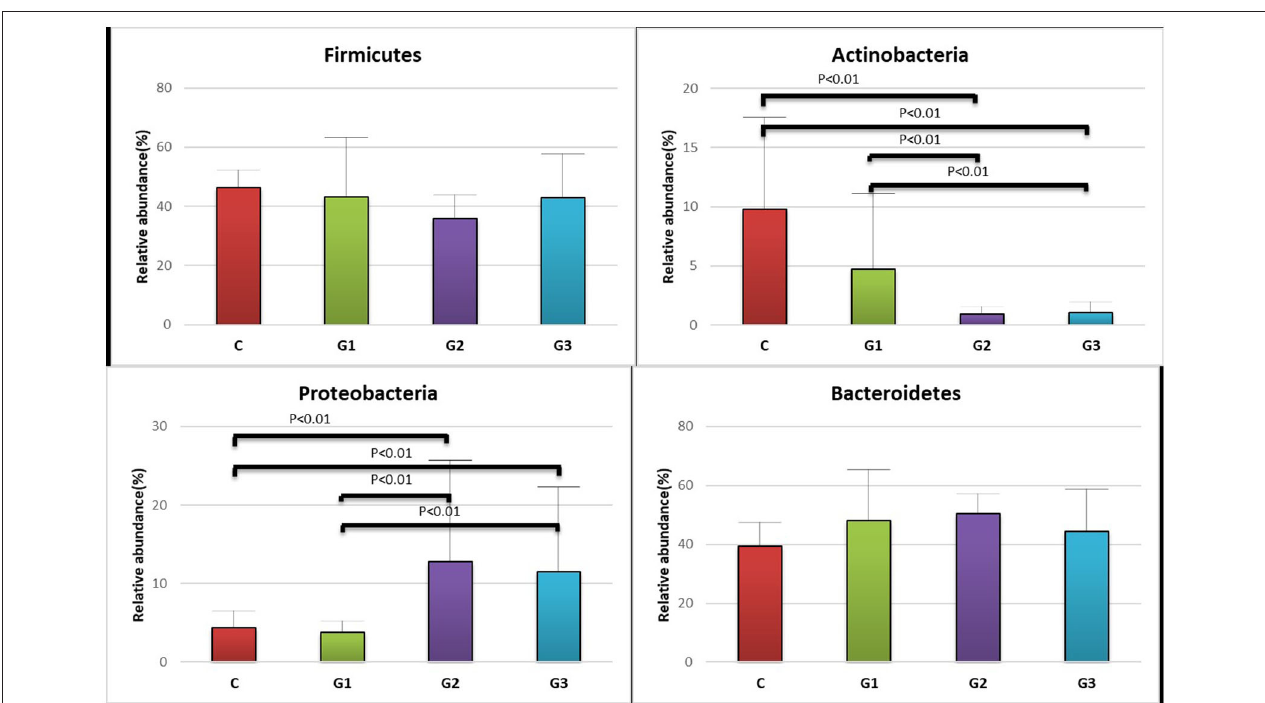
FIGURE 3 | Relative abundance of the intestinal flora at the family level in the four groups of children (Firmicutes, Actinobacteria, Proteobacteria, Bacteroidetes). The abscissa is the group name; the ordinate indicates the percentage of abundance of a particular intestinal flora; the column color corresponds to the legend color on the right. (A) Relative abundance (%) of Firmicutes in the intestinal flora of the four groups of children. (B) Relative abundance (%) of Actinobacteria in the intestinal flora of the four groups of children. (C) Relative abundance (%) of Proteobacteria, in the intestinal flora of the four groups of children. (D) Relative abundance (%) of Bacteroidetes, in the intestinal flora of the four groups of